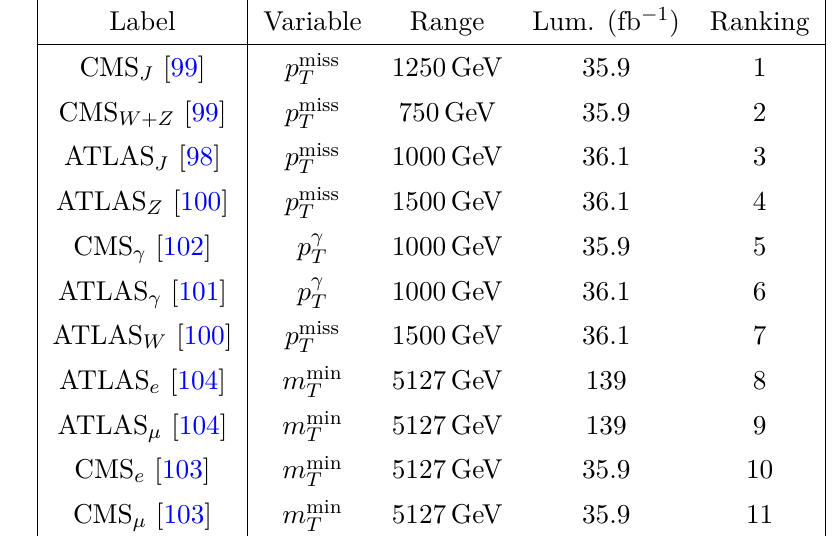
Table 1. Summary of various information on data sets used in this study, including the principal variable used in each data set, its highest value probed, the total luminosity, and a ranking of different data